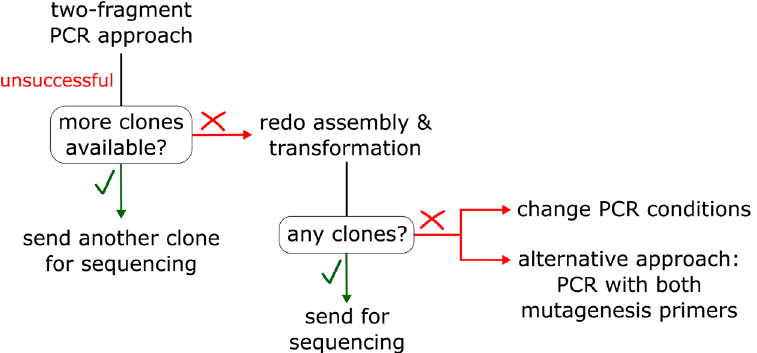
Figure 5. Troubleshooting scheme. For mutants which were not obtained in the first round of cloning, another clone can be sequenced, if it exists. Furthermore, the Gibson assembly reaction can be redone with the same purified DNA fragments, followed by bacterial transformation and sequencing. For missing mutants, PCR conditions can be changed or PCR containing both mutagenesis primers (one-fragment approach) can be